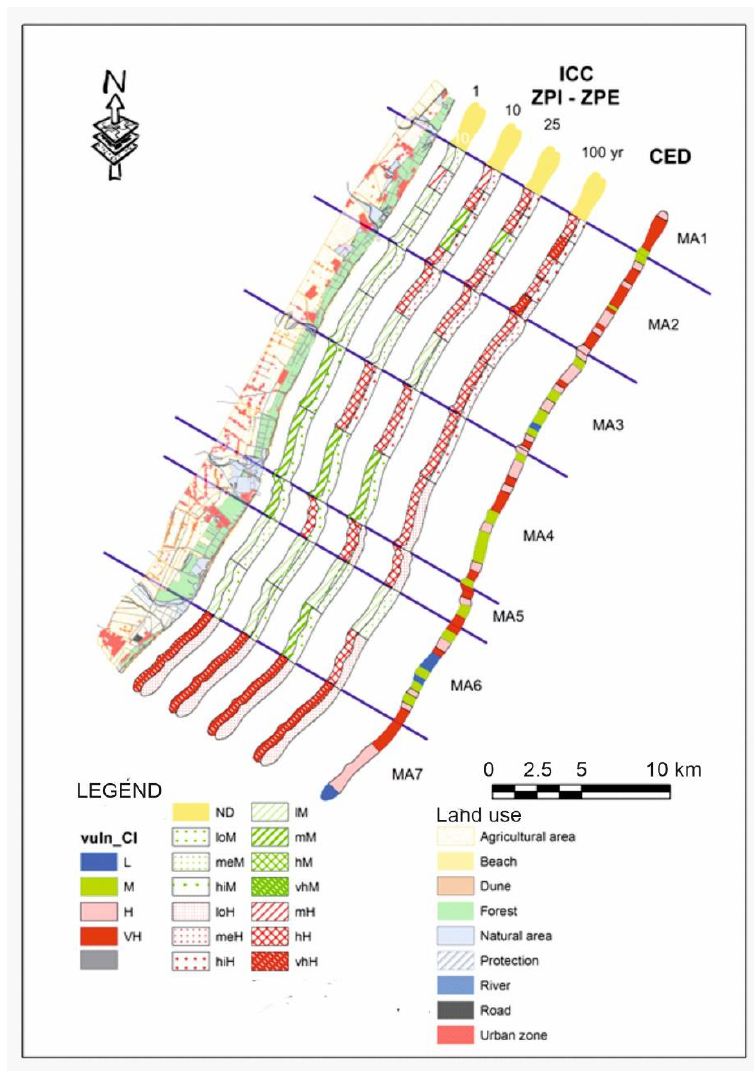
Figure 4. Synthesis of the results .